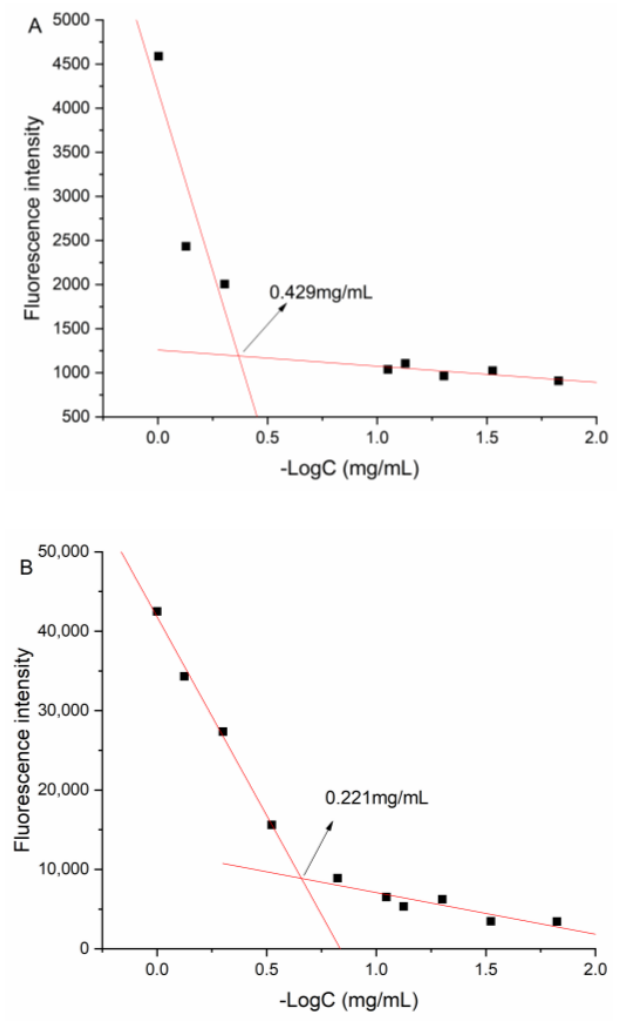
Figure 8. CMC value of ( A ) DNC/GA micelles; ( B ) DNC/GA/PVP K30 micelles.